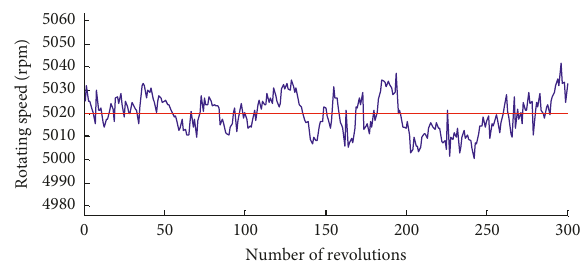
Figure 9: Experimental rotating speed.